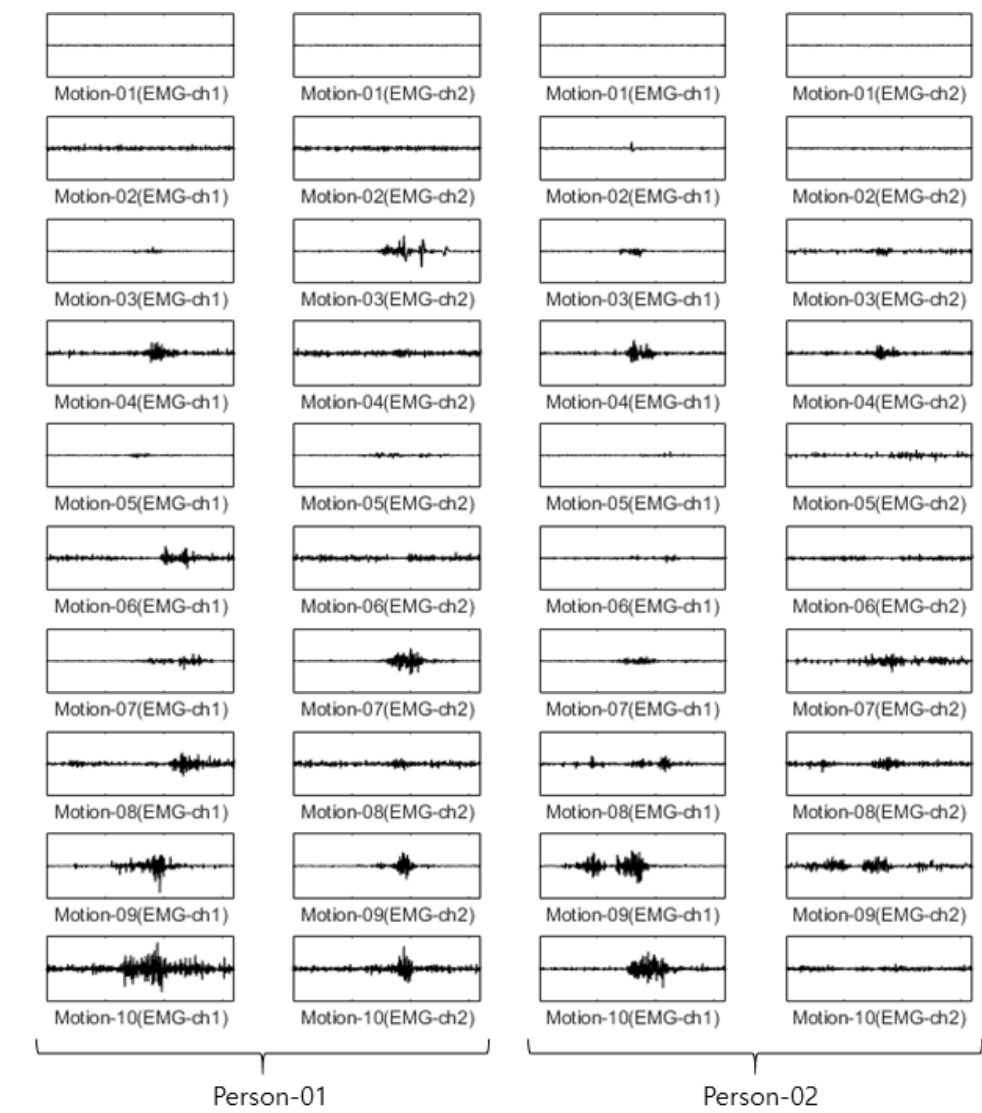
Figure 5. Some example of Angeles EMG dataset. Table 3. Accuracies on Test data according to wavelet type.